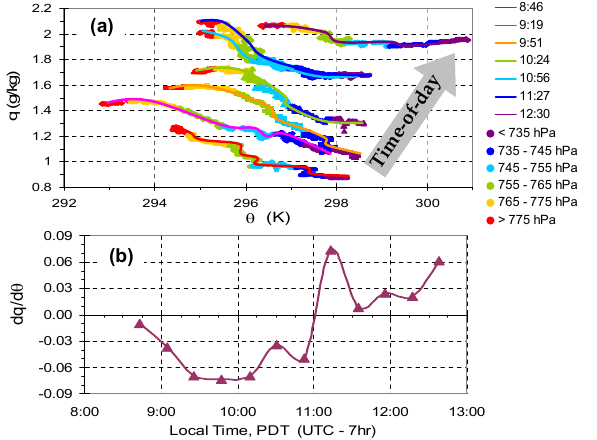
Figure 5. (a) An example “mixing diagram” (after the work of Berg & Stull, 2004) for 1 May 2008. The individual points along each line are averaged from 3 ascents presented in Fig. 4; the line atop the points represents a fit to the averaged points. All times are local (PDT = UTC – 7hr) and are the midpoints of the 3 ascents. Note the change in the shape of the curve (particularly at the summit, denoted here in cool colors) as the morning progresses. (b) An example dq/d θ vs. time-of-day plot for 1 May 2008. Points represent the average of 2 ascents presented in Fig. 4 to allow for greater resolution than panel (a).